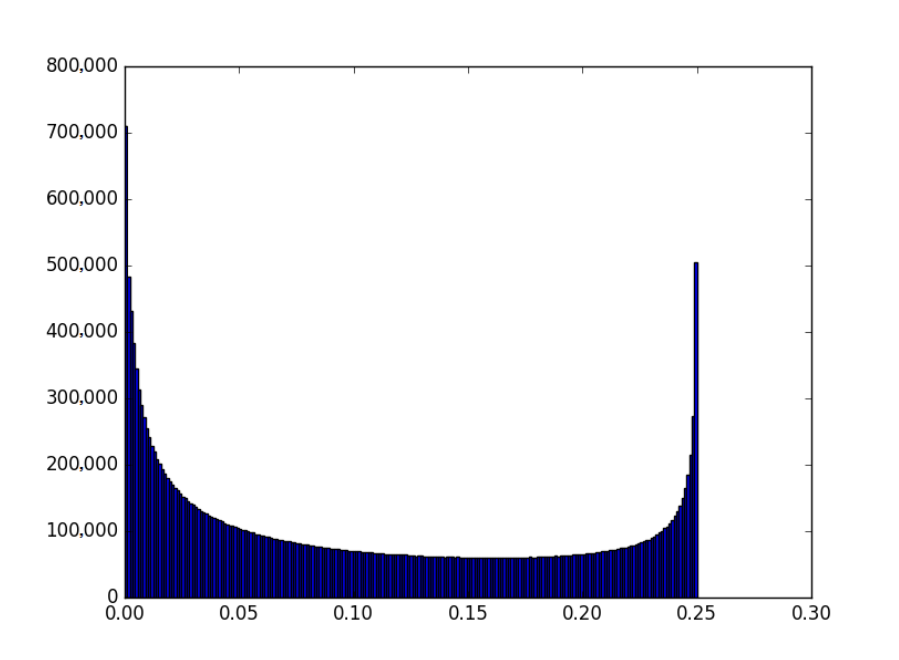
Figure 6. Distribution of γ 1 γ 2 on training set of MIR-1K dataset. γ 1 γ 2 is distributed between [0,